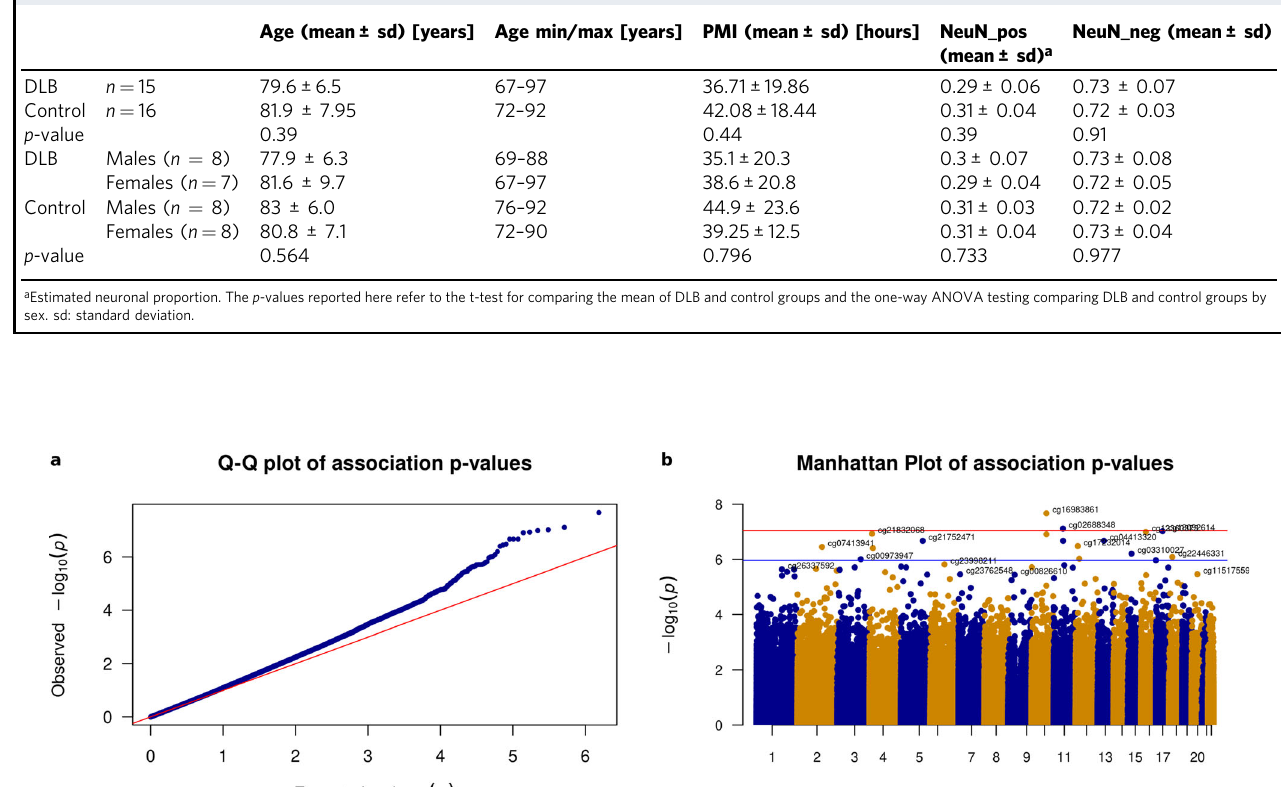
Table 1 Characteristics of samples investigated in this